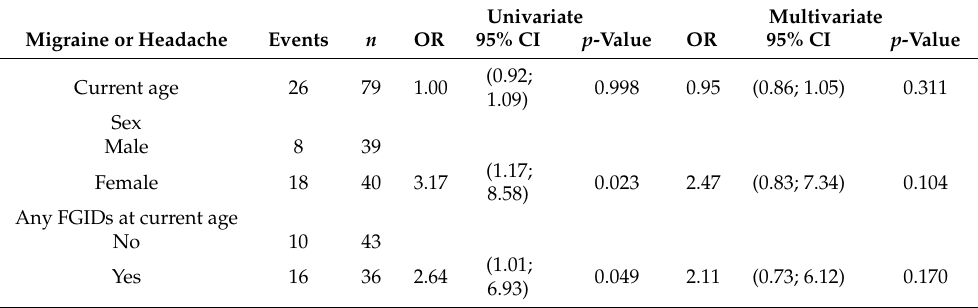
Table 3. Risk factors for migraine or